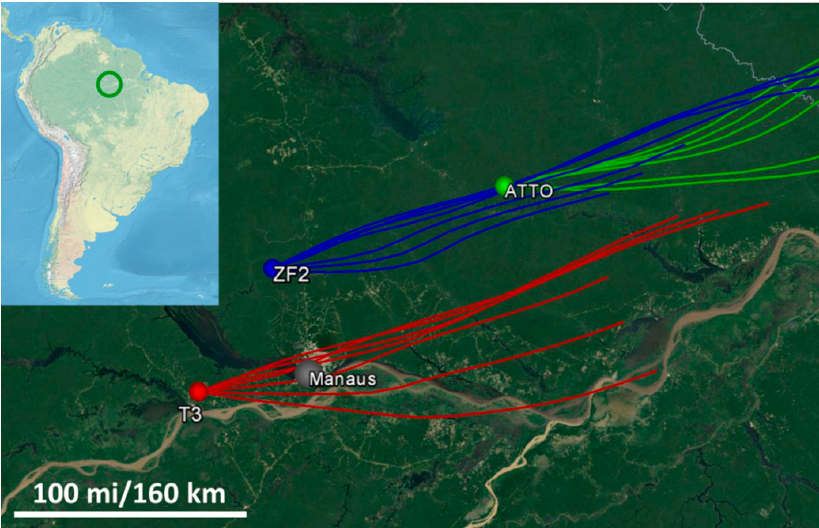
Figure 1. Positions of the three sampling sites located around the city of Manaus with representative National Oceanic and Atmospheric Administration (NOAA) Hybrid Single Particle Lagrangian Integrated Trajectory Model (HYSPLIT) back trajectories (14 September from 9:00 to 12:00 shown, 500 m starting elevation using the global data assimilation system data set) [41,42]. (Inset) Overview map of South America with the region of interest circled. Longer back trajectories as well as varied starting elevations for the three sites are shown in Figure S1 [28,34,40].